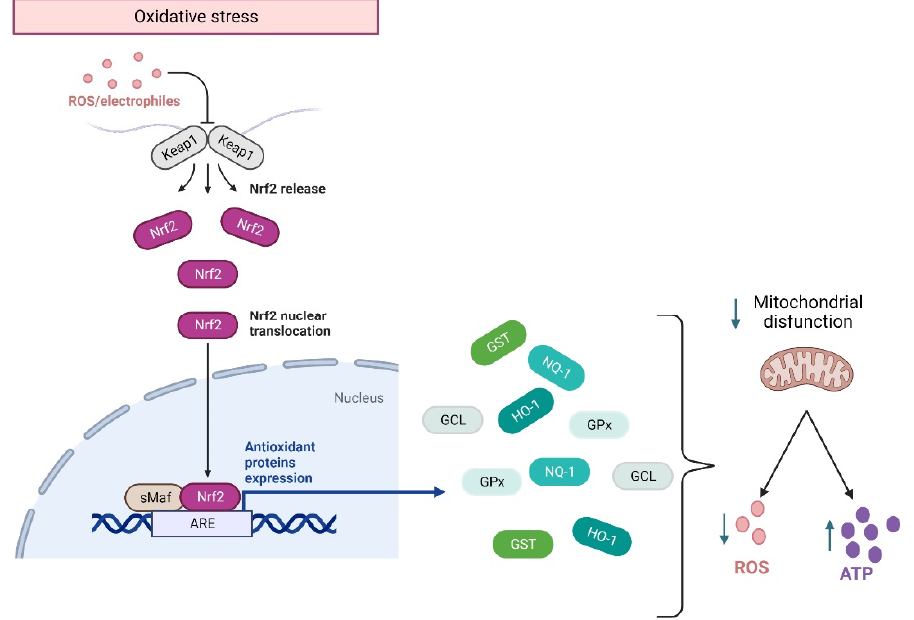
Figure 2. Nrf2 response to oxidative stress. Under an oxidative environment, Keap1 releases Nrf2, which translocates from the cytoplasm to the nucleus, where it binds to the ARE sequence, activating the anti-inflammatory response elements (ARE) pathway. This pathway allows for the transcription of genes that code for the main antioxidant enzymes, which will modulate mitochondrial damage by decreasing ROS and facilitating ATP synthesis. HO-1: heme oxygenase-1. NQO1: H quinone oxidoreductase-1. GST: glutathione S-transferase. GCL: glutamate-cysteine ligase. GPx: glutathione peroxidase. This figure was created in Biorender.